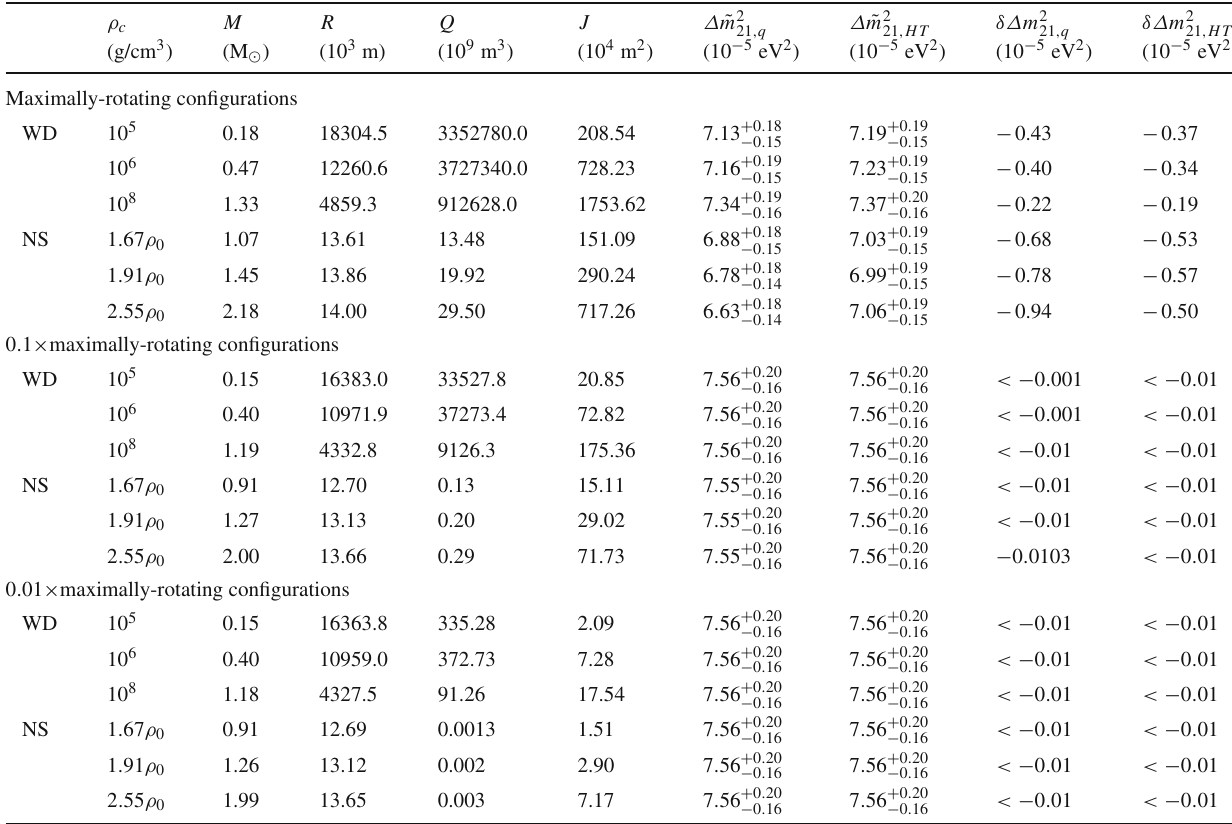
Table 2 The effects of the quadrupole moment (for q - and HT met- rics) and the dipole moment (for HT metric only), for both WDs and NSs, on Δ m 2 . All the parameters have been estimated for maximally-, 21 0 . 1 × maximally-, and 0 . 01 × maximally-rotating compact objects. In order, the columns list: the central density ρ c in g/cm 3 and in units of